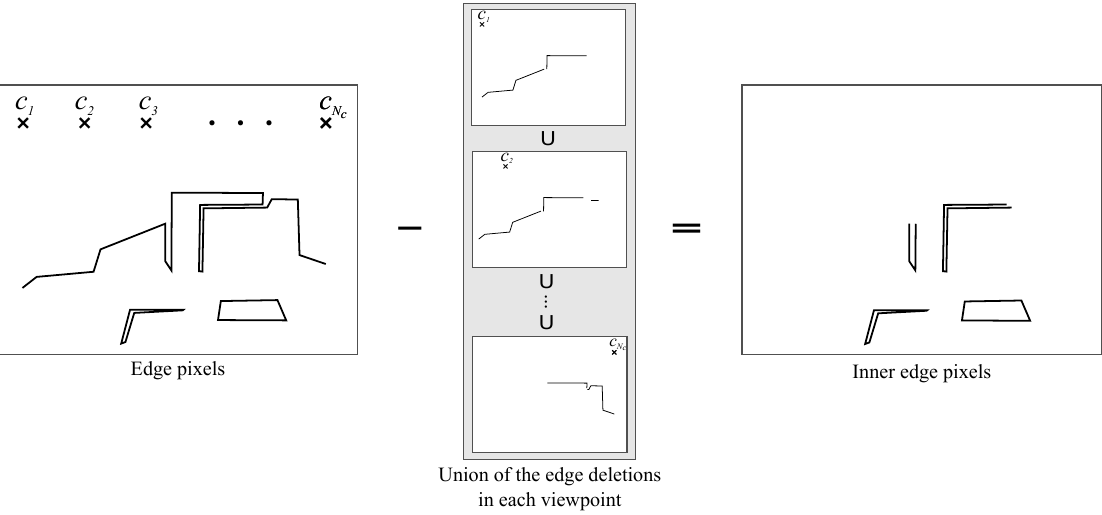
Figure 5. The hidden point removal (HPR) operator (black points indicate pixels visible from viewpoint c ).